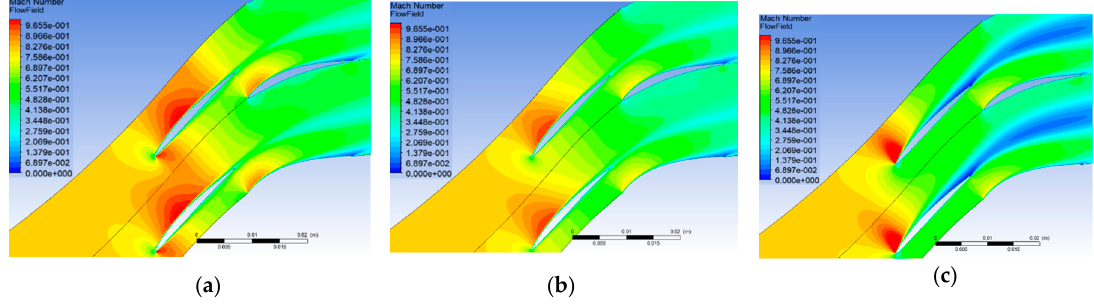
Figure 18. Baseline blade Mach contours in typical operating conditions. (a) i = − 5°; ( b ) i = − 1°; ( c ) i = +5°.